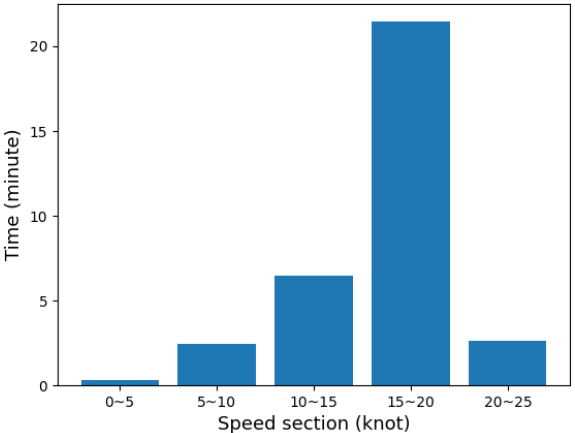
Figure 2. The data preprocessing procedure.